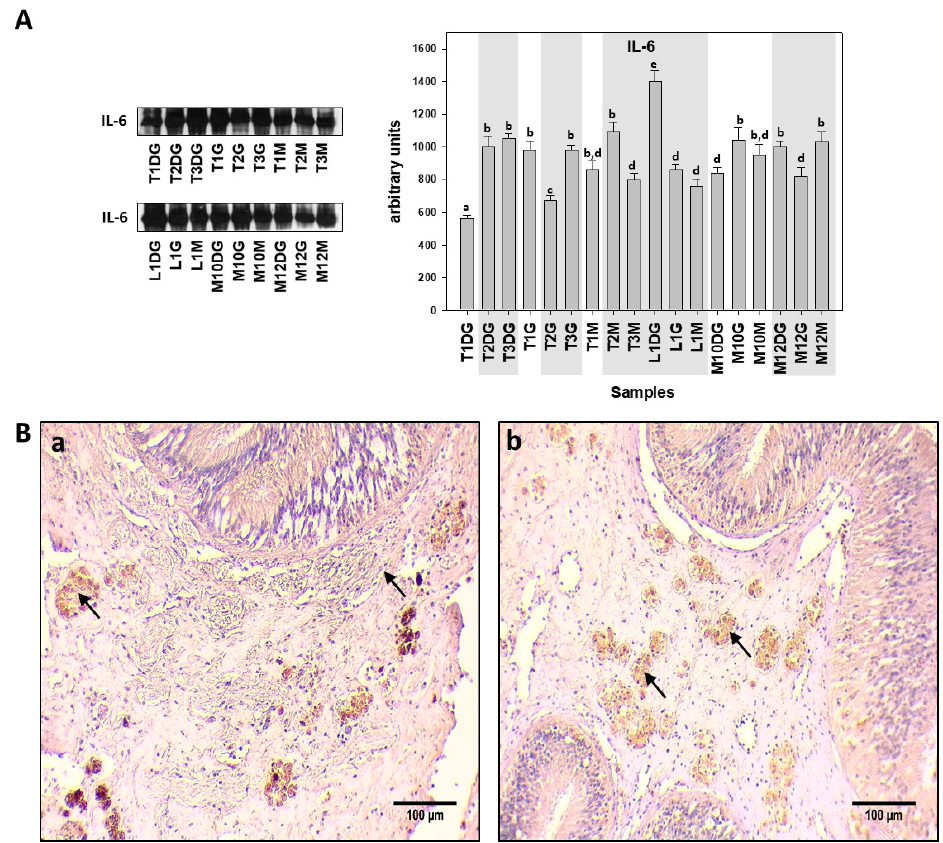
Figure 4. ( A ). Il-6 levels in the digestive gland (DG), gills (G), and mantle (M) of Pinna nobilis specimens from Kalloni Gulf (Lesvos Island) (M10, M12), Thermaikos Gulf (Thessaloniki) (T01, T02, T03), and Limnos Island (L1). All specimens were infected with mycobacteria and vibrios, while grey shaded areas represent specimens additionally infected with the haplosporidian parasite. Tissue extracts from all groups were immunoblotted for Il-6. Blots were quantified using scanning densitometry. Representative blots are shown. Lower-case letters indicate statistically significant differences ( p < 0.05) between samples. ( B ). ( a , b ) Immunohistochemical detection (arrows) of Il-6 in the connective tissue of P. nobilis digestive gland of non-infected ( a ) and infected ( b ) specimens by H. pinnae . (in Ba, left arrow indicates concentrated, while right arrow indicates scattered Il-6 detection). A similar pattern to the Il-6 expression was observed concerning TNFa. Thus, TNFa levels detected by Western blot analysis revealed differences between the H. pinnae infected and non- H. pinnae -infected individuals only in the digestive gland (DG) of Thermaikos gulf individuals (Figure 5A). The pattern expression of the TNFa by IHC detection was similar to Il-6 as described above (Figure